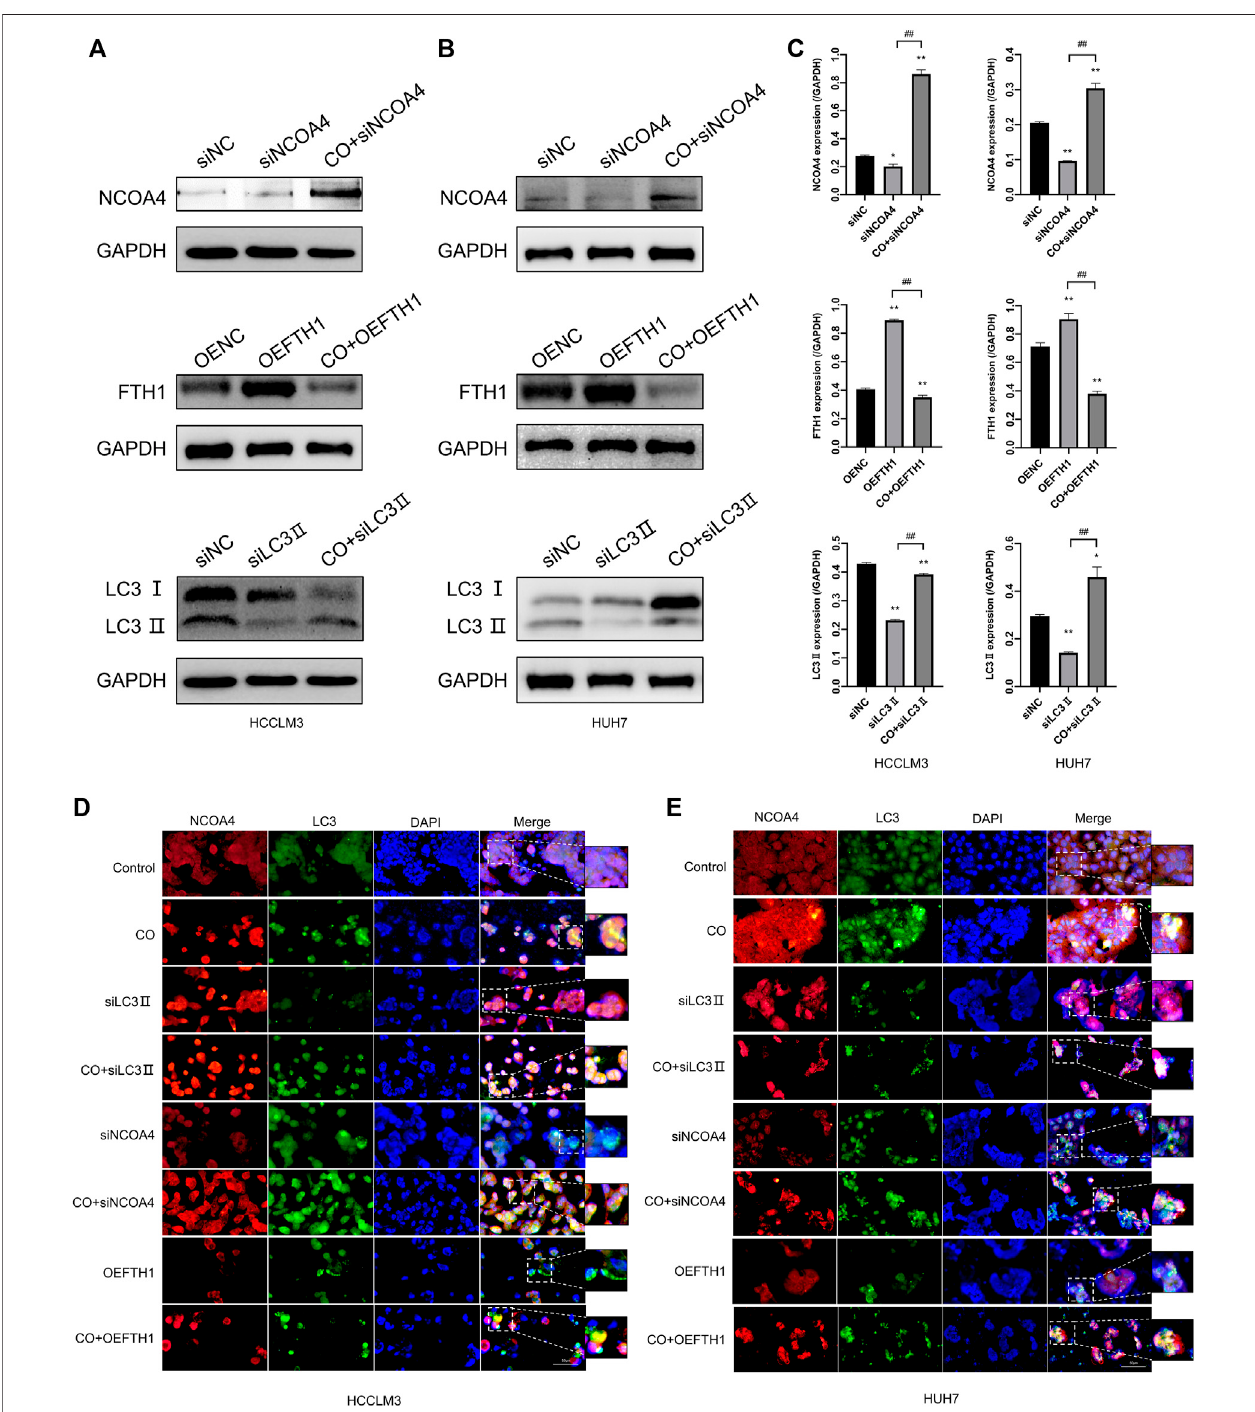
FIGURE 6 | Effects of caryophyllene oxide on ferritinophagy in HCCLM3 and HUH7 cells after siLC3 Ⅱ , siNCOA4 silencing, and OEFTH1 overexpression. (A) , (B) , and (C) Western blot identi fi ed the ef fi cacy of siLC3 Ⅱ , siNCOA4 silencing, and OEFTH1 overexpression, as well as the regulation of ferritinophagy-related proteins by caryophyllene oxide. The immuno fl uorescence staining (D) , (E) was used to examine the effect of caryophyllene oxide on the co-localization expression of NCOA4 and LC3II, as well as the effect of siLC3 Ⅱ , siNCOA4 silence, and OEFTH1 overexpression on the co-localization expression of NCOA4 and LC3II. The data were presented as mean ± SD. * p < 0.05, ** p < 0.01 when compared to the NC group. # p < 0.05, ## p < 0.01 when compared to the siLC3, siNCOA4, and OEFTH1 groups.